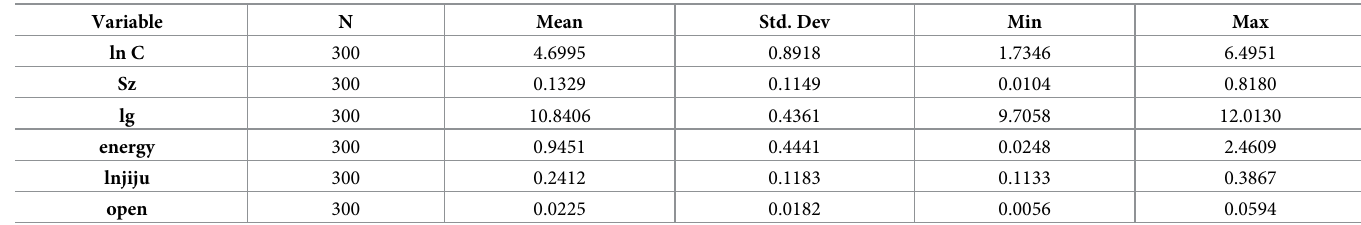
Table 3. Descriptive statistics of each